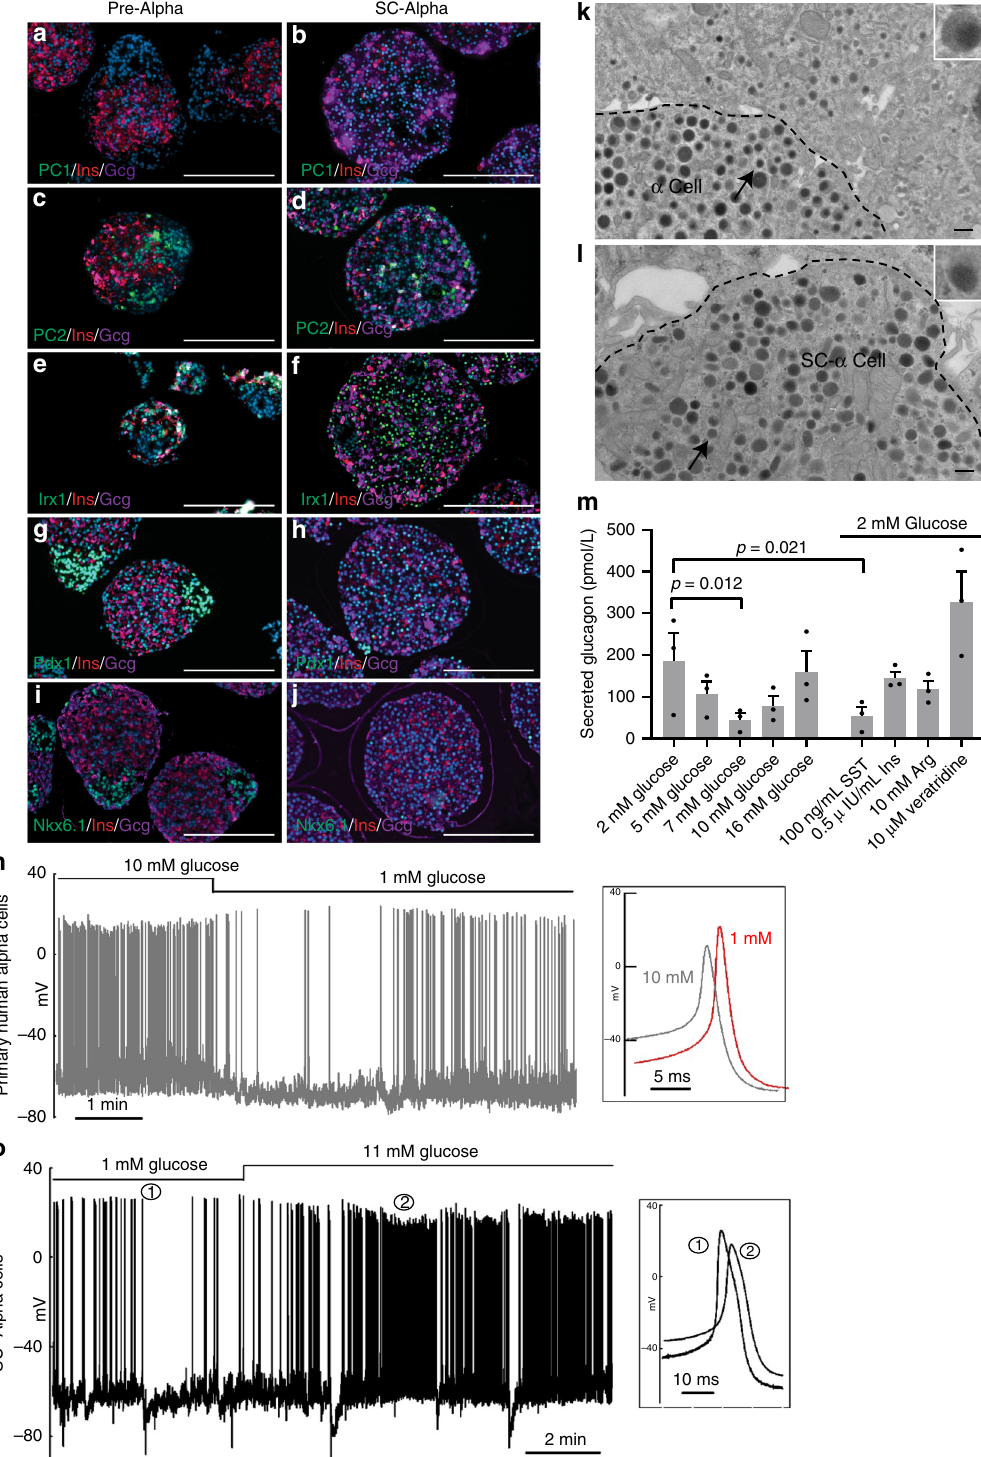
Fig. 5 Characterization of SC-alpha cells. Pre-alpha ( a , c , e , g and i ) and SC-alpha cells ( b , d , f , h , and j ) stained for PC1 ( a and b ), PC2 ( c and d ), IRX1 ( e and f ), PDX1 ( g and h ), and NKX6.1 ( i and j ). Scale bar for a − j = 200 μ m. The ultrastructure and granule morphology of human cadaveric alpha cells ( k ) and SC-alpha cells ( l ) as assessed by electron microscopy are similar. Arrows indicate granules; dashed line denotes the cell boundary. Inlay shows granule morphology. Scale bar for k and l = 500 nm. m SC-alpha cells secrete glucagon in response to glucose and are inhibited by somatostatin (SST). SC- alpha cell response to the glucagon secretagogue veratridine. Data are presented as mean ± SEM, signi fi cance calculated using a paired ratio Student ’ s t test ( n = 3 biologically independent samples). n Representative electrophysiology recording of primary human alpha cell showing electrical activity in response to low (1 mM) and high (10 mM) glucose. Amplitude differences at low and high glucose are shown in the inlay (representative; n = 5 biologically independent cells). o Representative electrophysiology recording of SC-alpha cell showing electrical activity in response to low (1 mM) and high (11 mM) glucose. Amplitude differences at low and high glucose are shown in the inlay (representative; n = 30 biologically independent